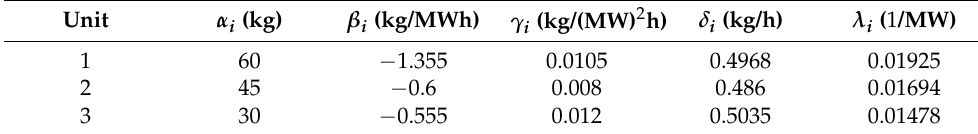
Table 6. Gas emission parameters of thermal power units.